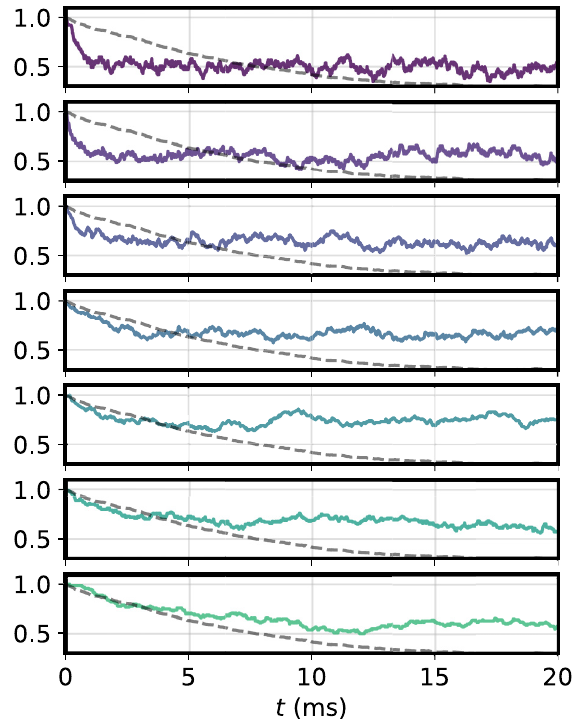
FIG. 13. The overlap F for different values of the cor- rector position | R L 1 | = | R L 2 | obtained from simulating 10 2 quantum trajectories. For each trace position, the values are ( 0.47, 0.52, 0.58, 0.63, 0.69, 0.74, 0.80 ) μ m from top to bottom, respectively. The gray dashed lines represent the overlap of free decohering spins, for comparison. All remaining parameters are the same as in Fig. 6 in the main